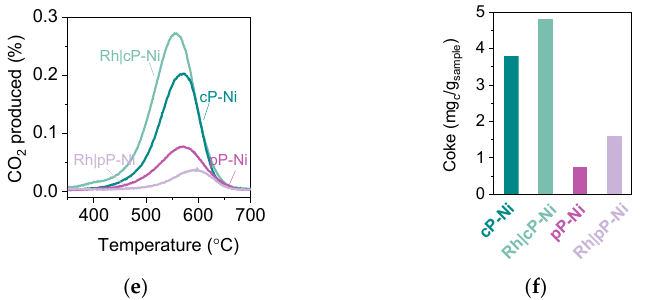
Figure 7. Activity of the Rh infiltrated exsolved perovskites. ( a ) Methane conversion to CO and H2 observed for the coarse powder samples. ( b ) Methane conversion to CO and H2 observed for the pellet samples. ( c ) Capacity of the samples in molO/molp derived from MTPR and HTPR. ( d ) Comparison of activation temperature achieved by the samples in (a) and (b). ( e ). CO 2 produced during oxidation of the samples after MTPR testing and ( f ) the calculated coke for the experiment described in (e).